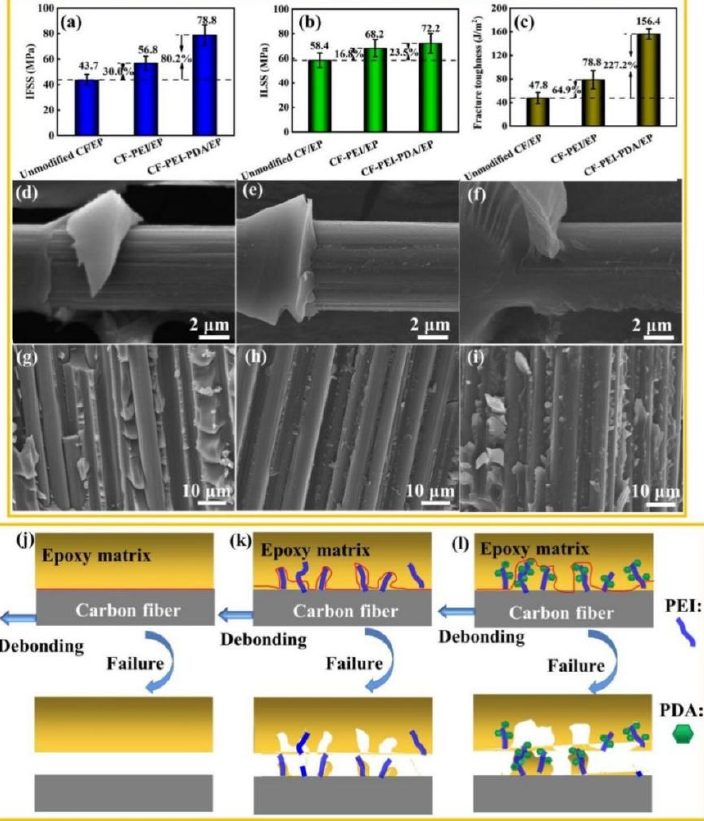
Figure 6. ( a ) IFSS; ( b ) ILSS; ( c ) Fracture toughness; SEM images of de-bonding morphologies of the monofilament, profile-section fracture morphologies of the CF/EP composites and the schematic of failure mode for: ( d , g , j ) Unmodified CF/EP, ( e , h , k ) CF-PEI/EP and ( f , i , l ) CF-PEI-PDA/EP.